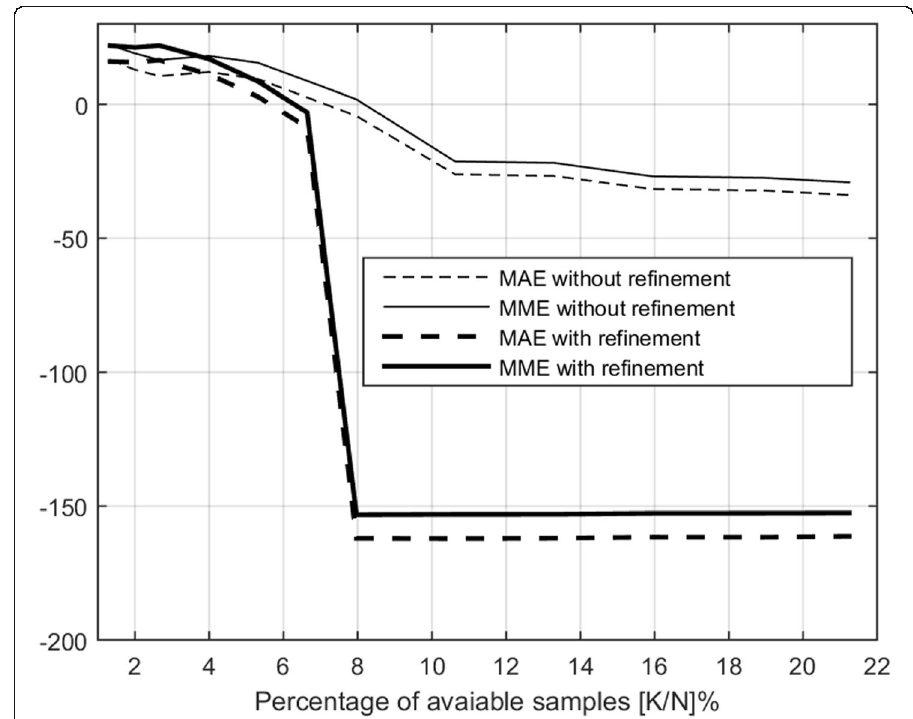
Fig. 7 Statistics (MAE — dashed lines, MME — solid lines) for the RANSAC application to the fifth-order phase PPS: thin lines — without refinement; thick lines — with refinement)